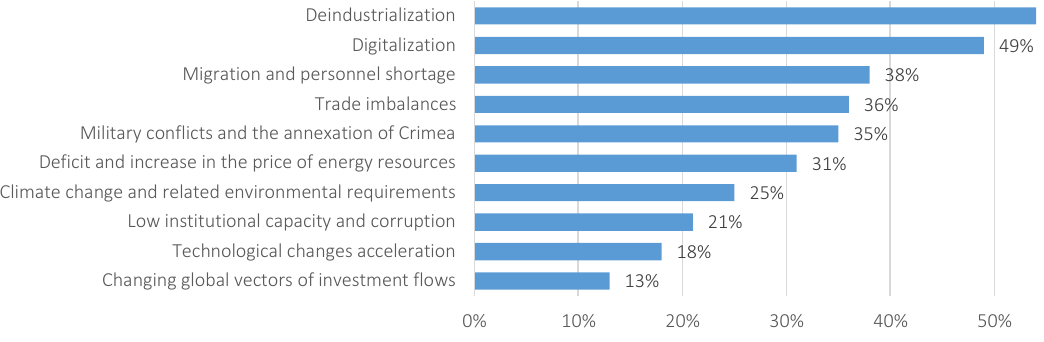
Figure 3. Environmental threats among general